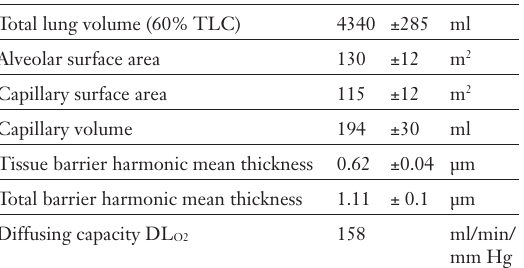
Alveolar capillary bounded by endothe- lial cell sits in alveo- lar septum lined by type 1 epithelial cells on both sides. Note thin tissue barrier on top and slightly thicker barrier with some connective tis- sue fibres and fibro- blasts at bottom.